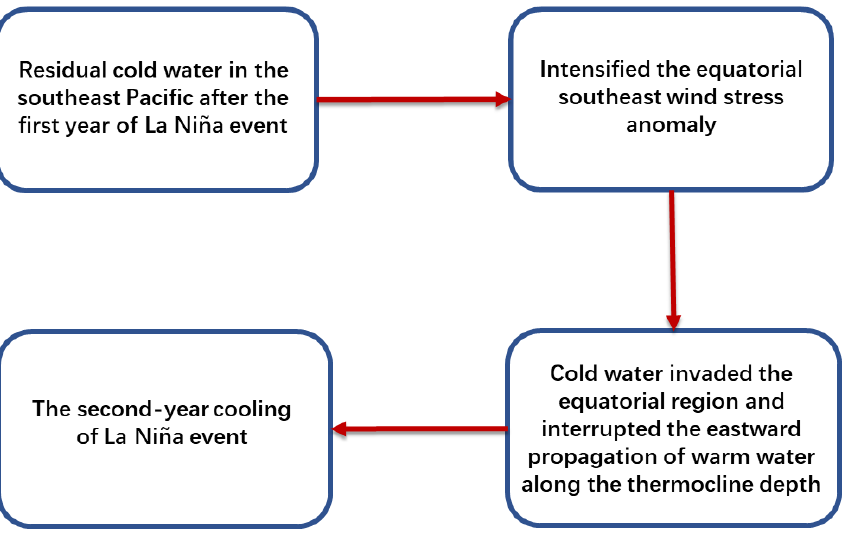
Figure 11. Schematic diagram of the occurrence of the second-year cooling of La Niña event in 2021.